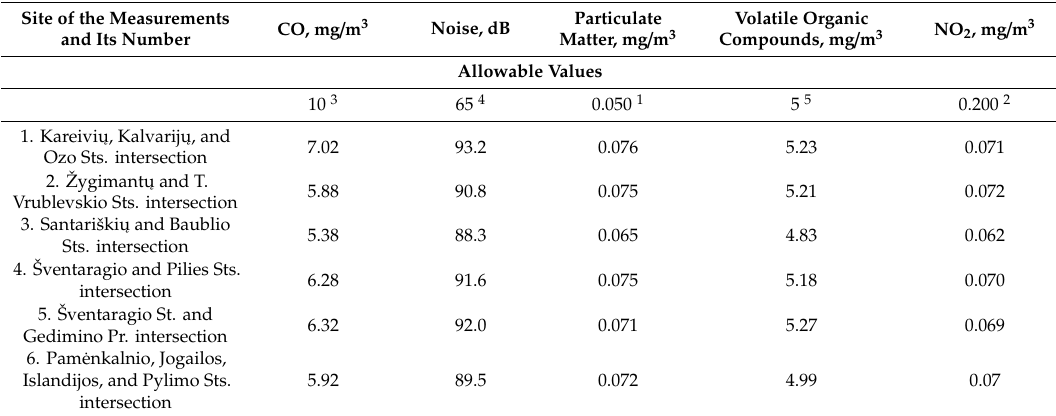
Criteria defining the depersonalized emotional–physiological states of passers-by at six sites, including happiness, sadness and, anger, as well as valence and heart rate (see Section 4.1.3). Table 1. Data on the air and noise pollution measurements at the six Vilnius city